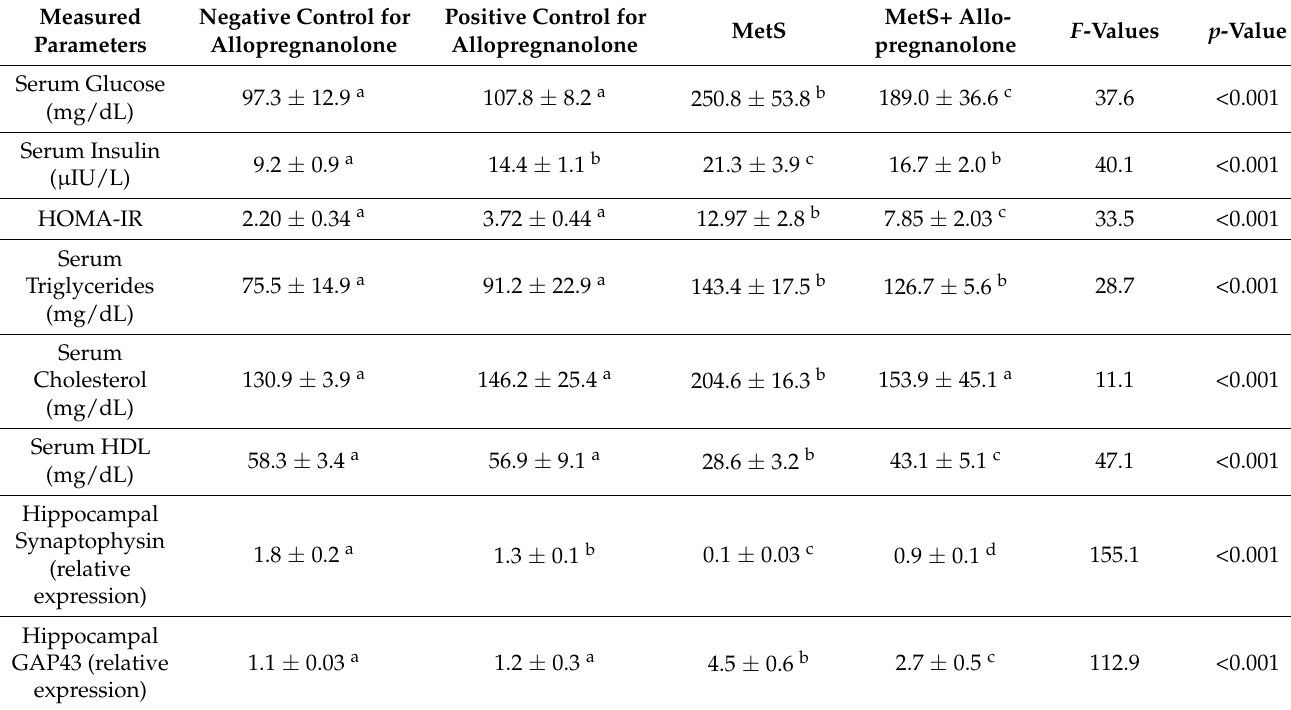
Table 2. Biochemical serum and hippocampal markers.